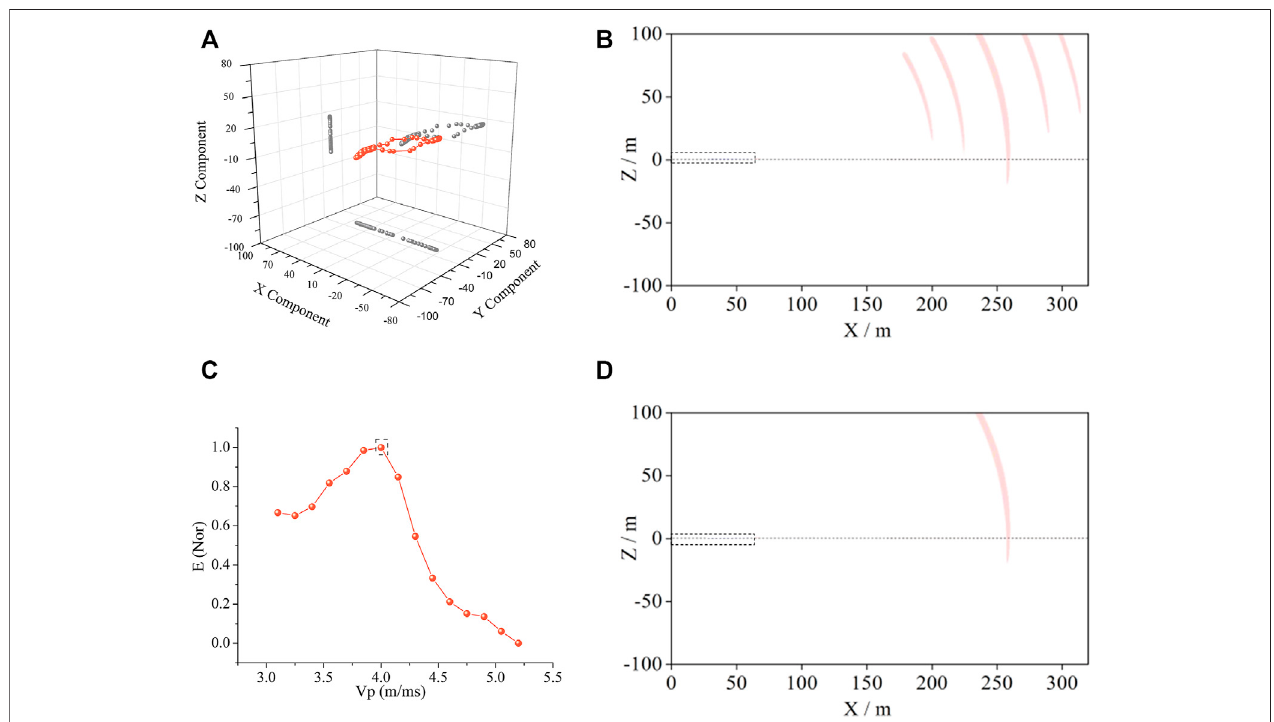
FIGURE 7 | Polarization migration results of the second interface. (A) represents the particle vibration of No. 2 receiver. The polarization migration results in (B) are obtained by superposing all the 16 receivers. Since the migration results corresponding to 15 velocities (in part (C) ) are dif fi cult to display, the polarization migration interfaces corresponding to fi ve velocities at relatively large intervals are selected. According to the velocity of Vp in (C) and the principle polarization angle in (A) , polarization migration interface is con fi rmed.